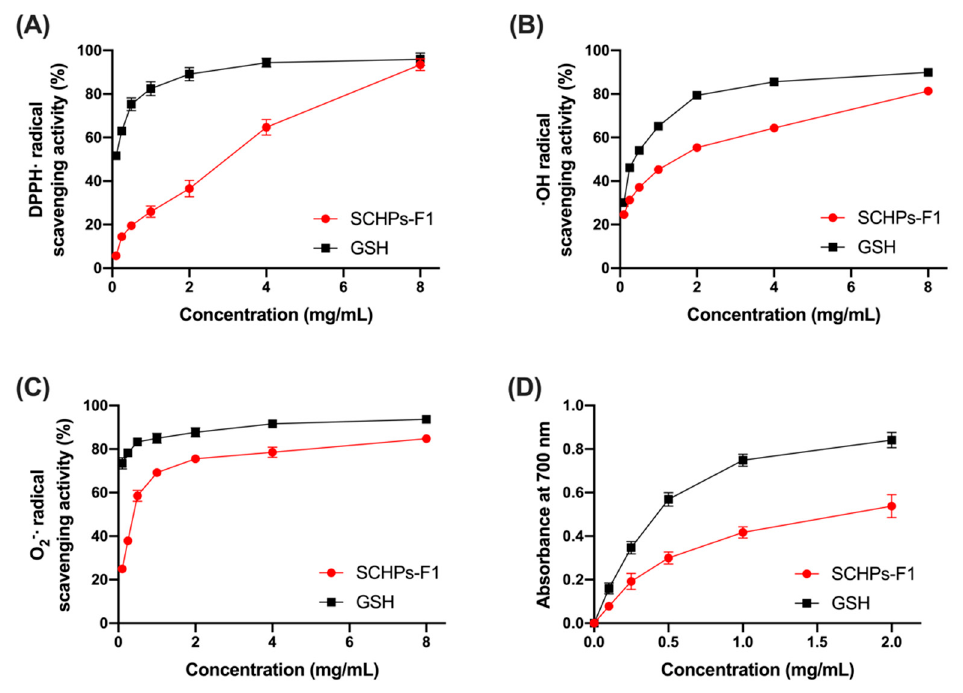
Figure 2. Antioxidant activity in vitro of SCHPs-F1 determined by DPPH • ( A ), • OH ( B ), and O 2 •− ( C ) scavenging activities, and ferric ion-reducing power ( D ) of SCHPs-F1. Reduced glutathione (GSH) serves as a positive control.